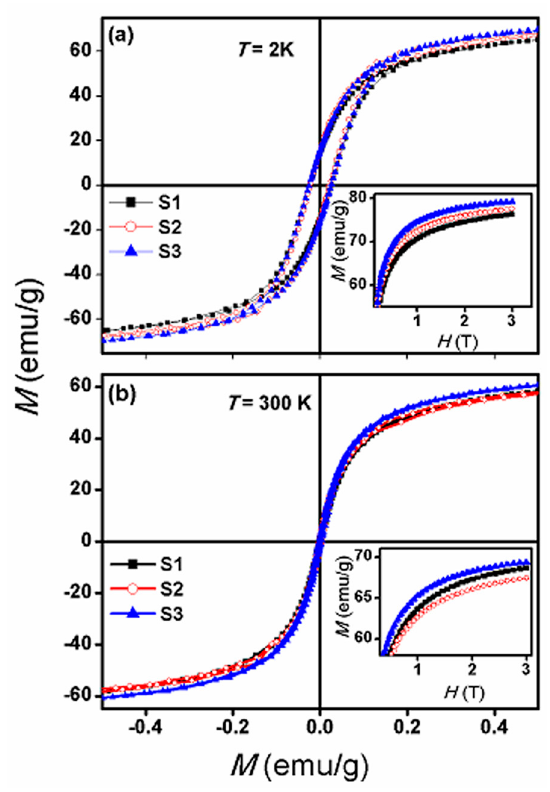
Figure 10. Magnetic hysteresis loops for all samples at 2 K and 300 K. The insets show initial magnetization curves up to 3 T. ( a ) at 2 K, and ( b ) at 300 K.